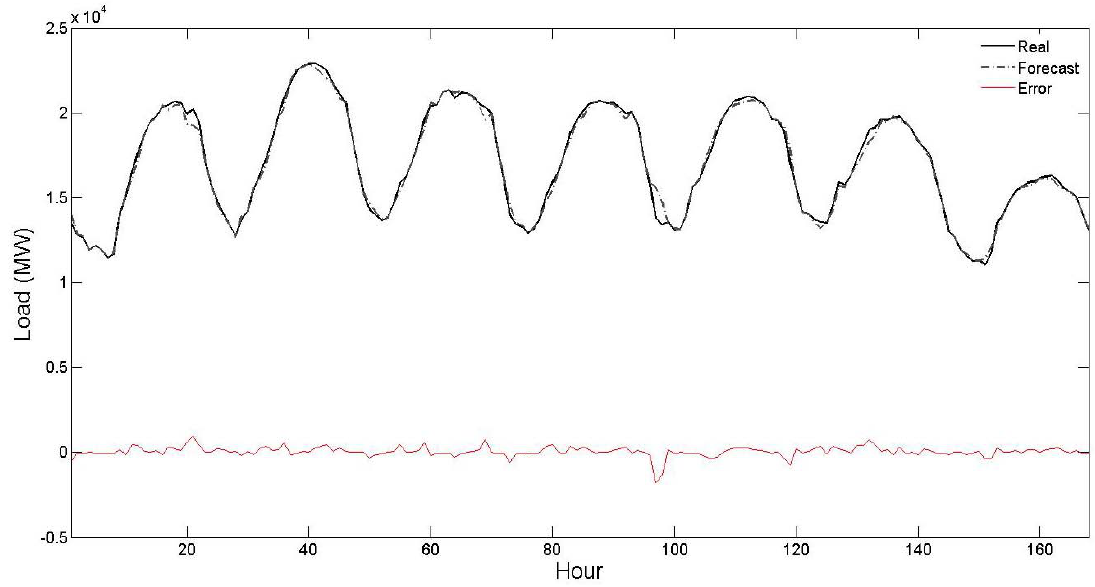
Figure 4. Curves of real values, forecast values and forecast errors for the third test week of Table 1 (the forecast results are related to the proposed strategy).